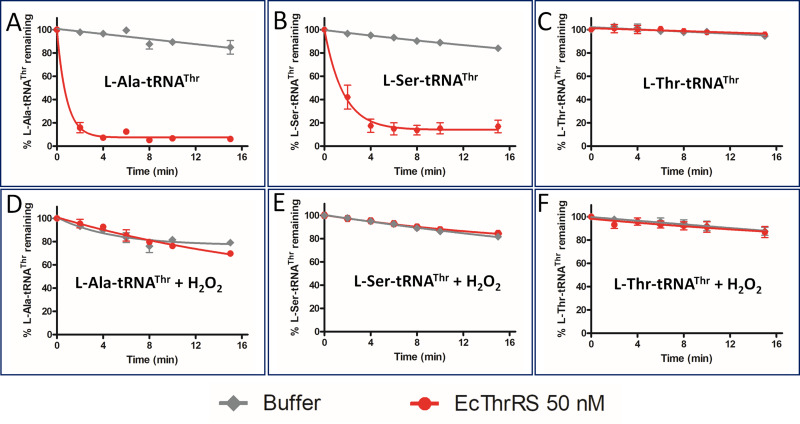
E. coli ThrRS proofreads L-Ala-tRNAThr and is sensitive to oxidative stress.Deacylation of various substrates (L-Ala/L-Ser/L-Thr-tRNAThr) by EcThrRS in presence and absence of 5 mM H2O2.Figure 3—figure supplement 1—source data 1.ThrRS editing is sensitive to oxidative stress but not ATD.